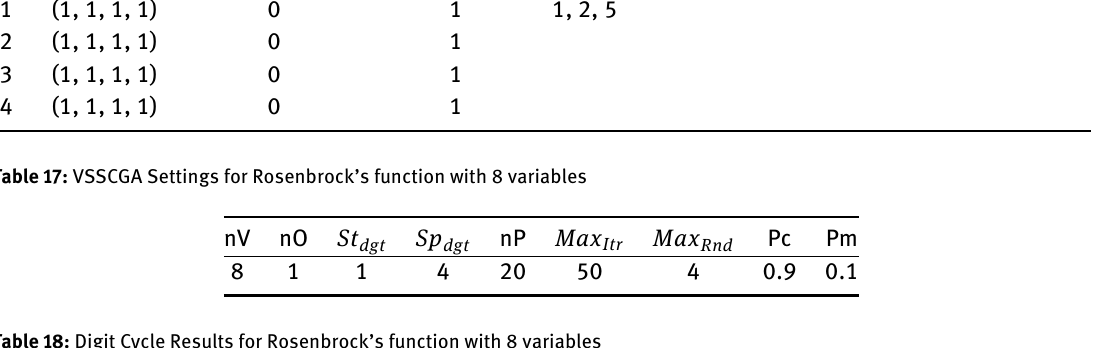
Table 18: Digit Cycle Results for Rosenbrock’s function with 8 variables nD